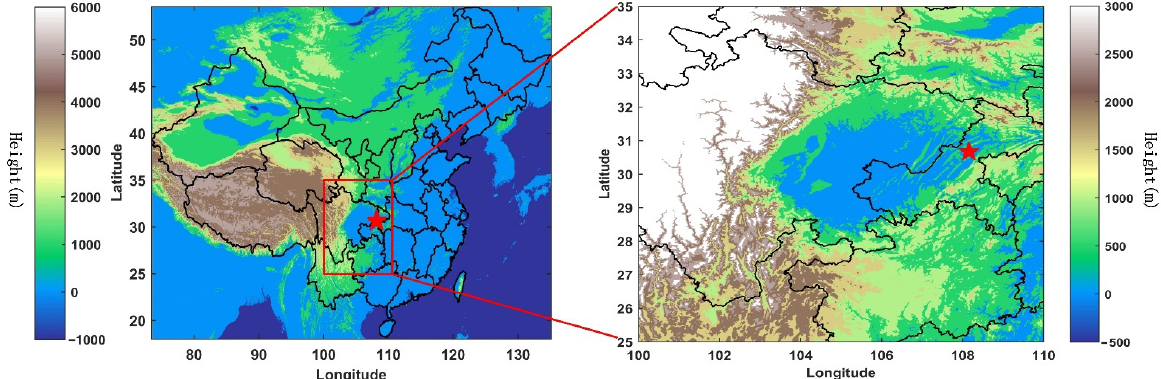
Figure 1. Geographic location of the Sichuan Basin and the field campaign site represented by the five-pointed star.